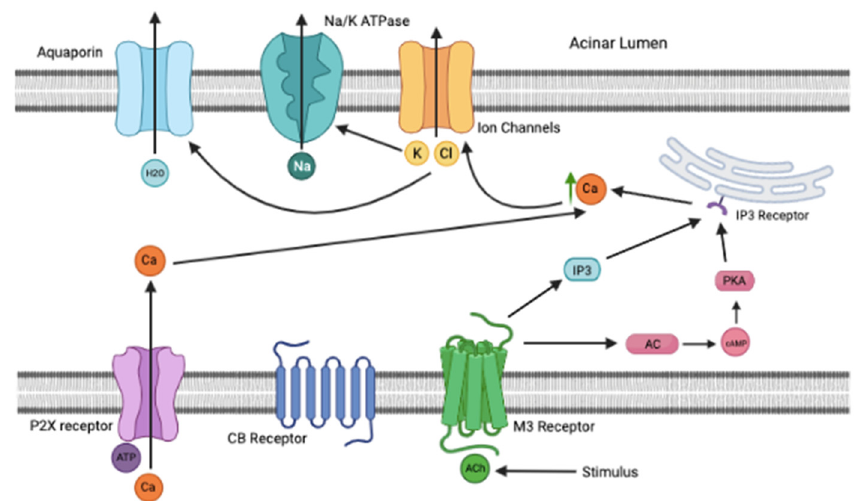
Figure 1. M3 Pathway. A stimulus causes release of Acetylcholine (ACh) which activates M3 receptors. This activation leads to increased levels of IP3 and cAMP, causing intracellular calcium release from the endoplasmic reticulum. Meanwhile, ATP activates the P2X receptor which allows extracellular calcium to move intracellularly and adds to the total intracellular calcium content. The elevated intracellular calcium causes opening of the Chloride ion channel, which then causes sodium and water to follow into the acinar lumen via Na/K ATPase and Aquaporin channels, respectively. Created with BioRender.com (accessed on 1 April 2022).